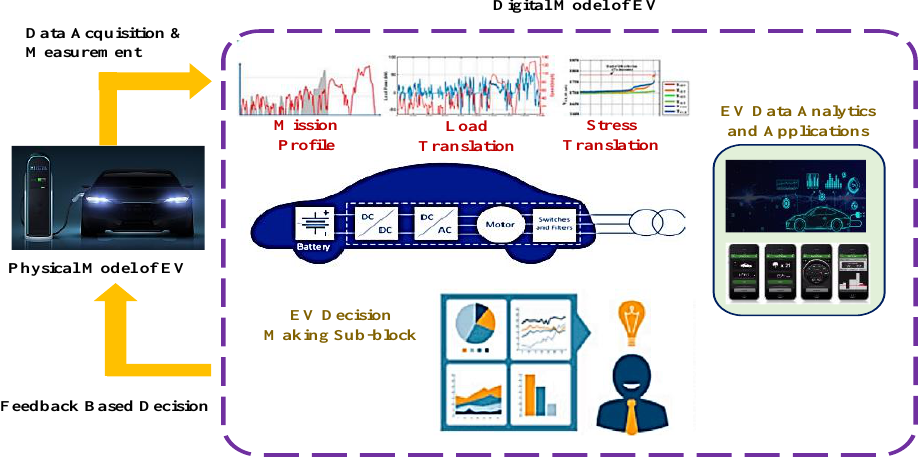
Figure 1. The creation of a digital twin implementation concept.